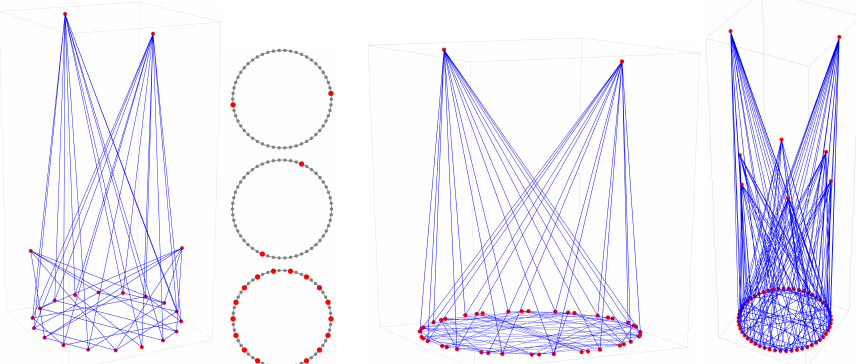
Figure 6. ¯ G 3 3 and corresponding slices ( first and second panels ), ¯ G 7 2 ( third panel ), and ¯ G 3 4 ( fourth panel